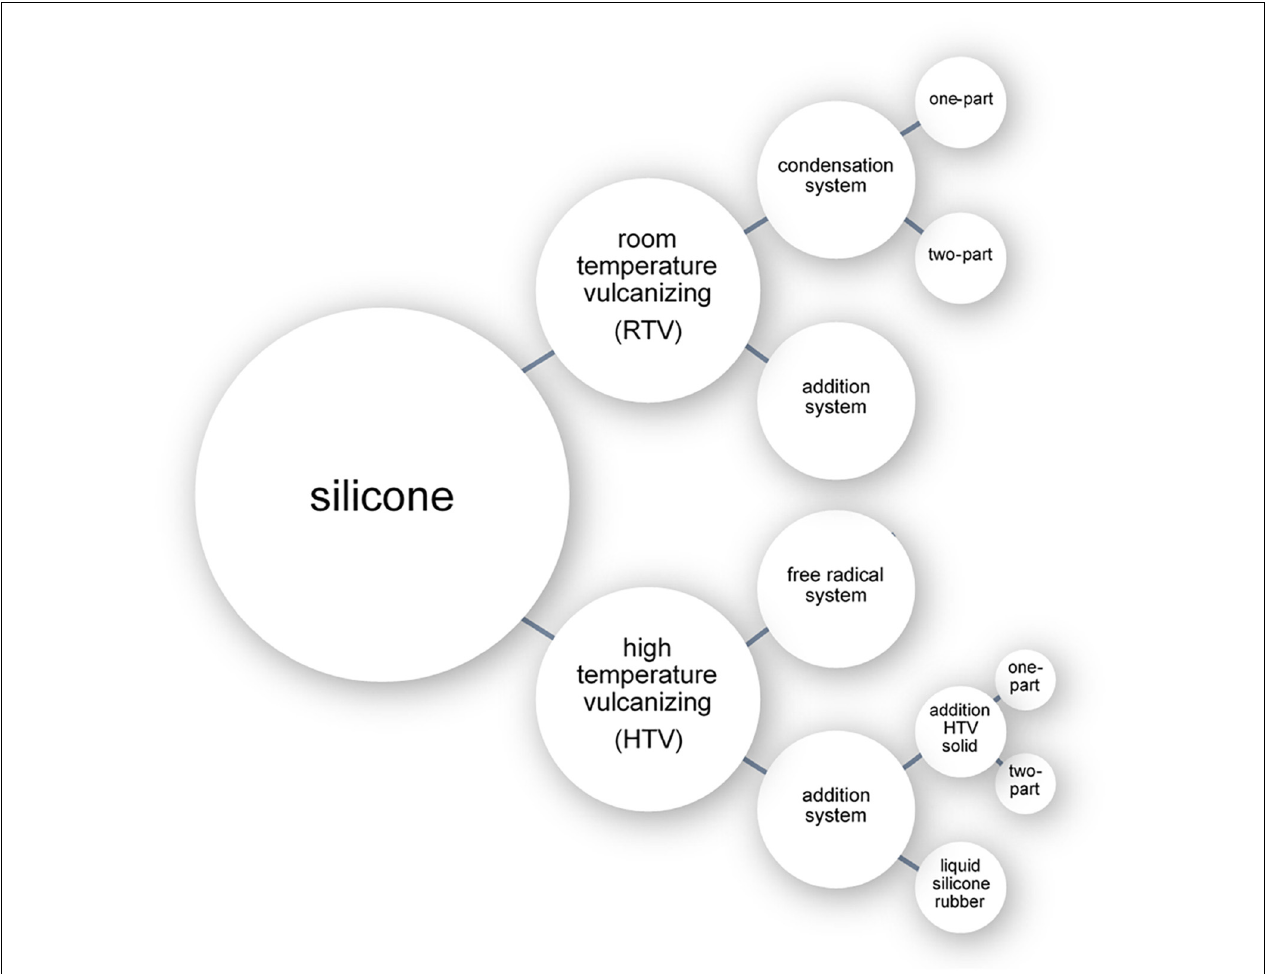
FIGURE 1 | Diagram of the different classes of